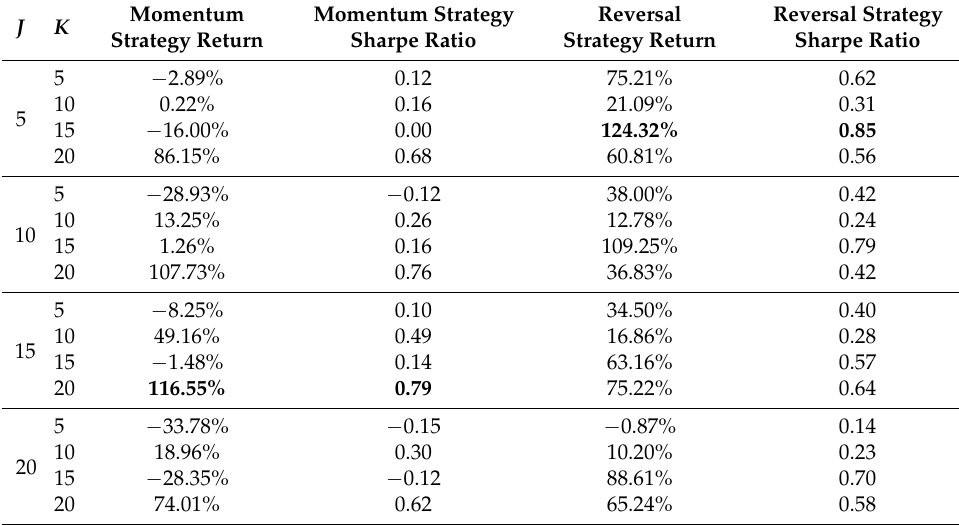
Table 5. Performance of the momentum and reversal trading